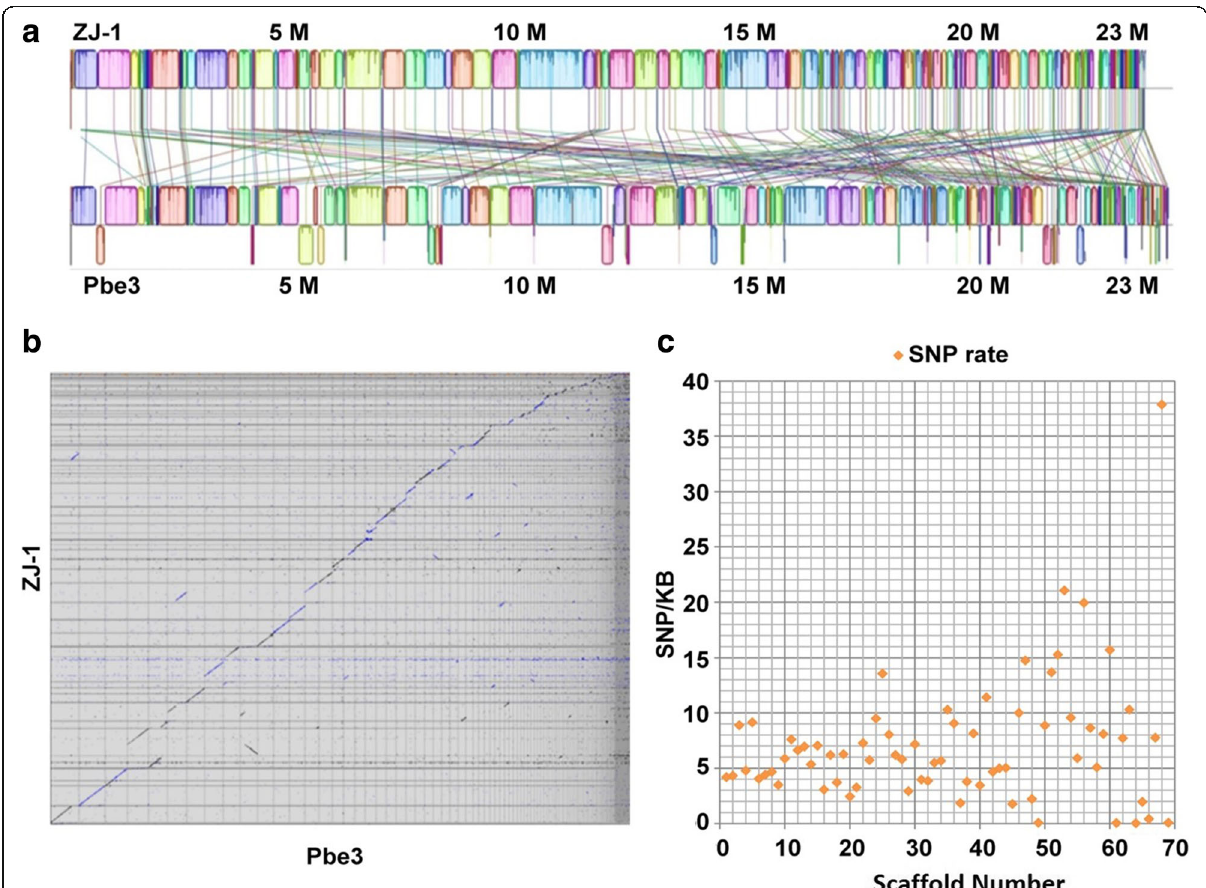
Fig. 1 Whole genome comparison and analysis between Plasmodiophora brassicae strain ZJ-1 and Pbe3. a Simple global view of syntonic alignments from the scaffolds larger than 10 kb. The minimum weight parameter is set by default. The matching regions (minimum set of local collinear blocks) represent as connected blocks. Each sequence of identically colored blocks represents a collinear set of matching regions. One connecting line is drawn per collinear block. Blocks below a genome ’ s center line are inverted relative to the reference sequence. b Whole-genome dot-plot comparison between P. brassicae strain ZJ-1 and Pbe3. c The statistic distribution of SNP rates from different scaffolds between the two